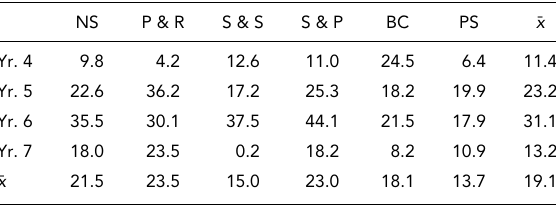
Average Percentage Increase between Fall and Spring Assessment for All Years (Grades) for Indigenous Students Across the Three Years of the Study (with Overall Average by Subtest)